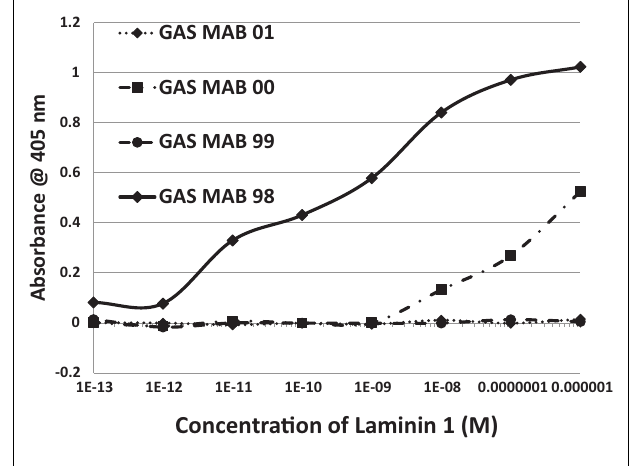
FIGURE 6 | Results of ELISA experiments involving monoclonal antibodies against groupA streptococci (GAS MAB) binding to myosin . Binding constants for Table 3 were derived from the inflection points of the curves.